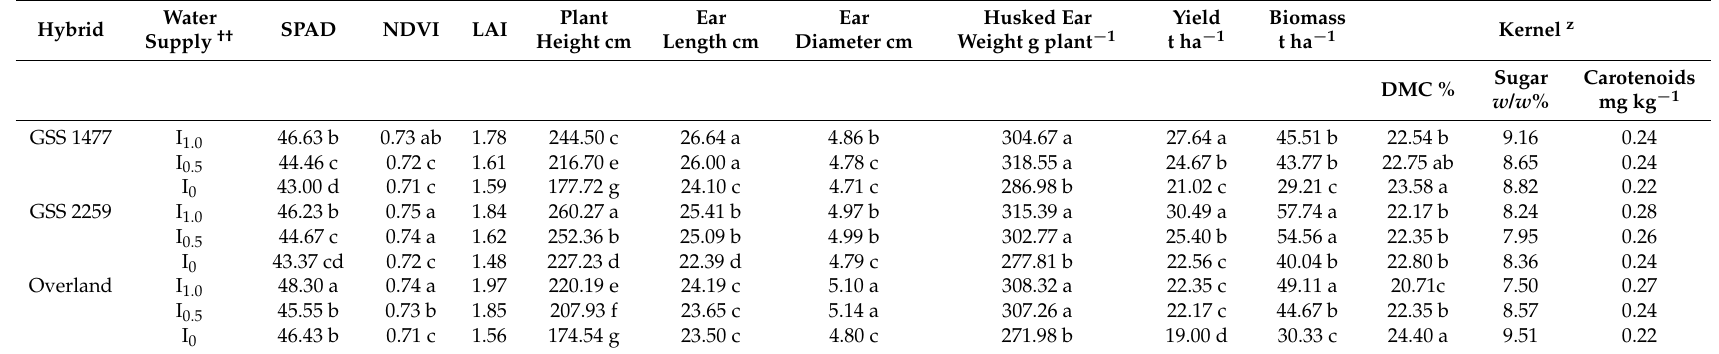
Table 6. Effect of water supply on the spectral traits, yield and nutritional quality of sweet corn